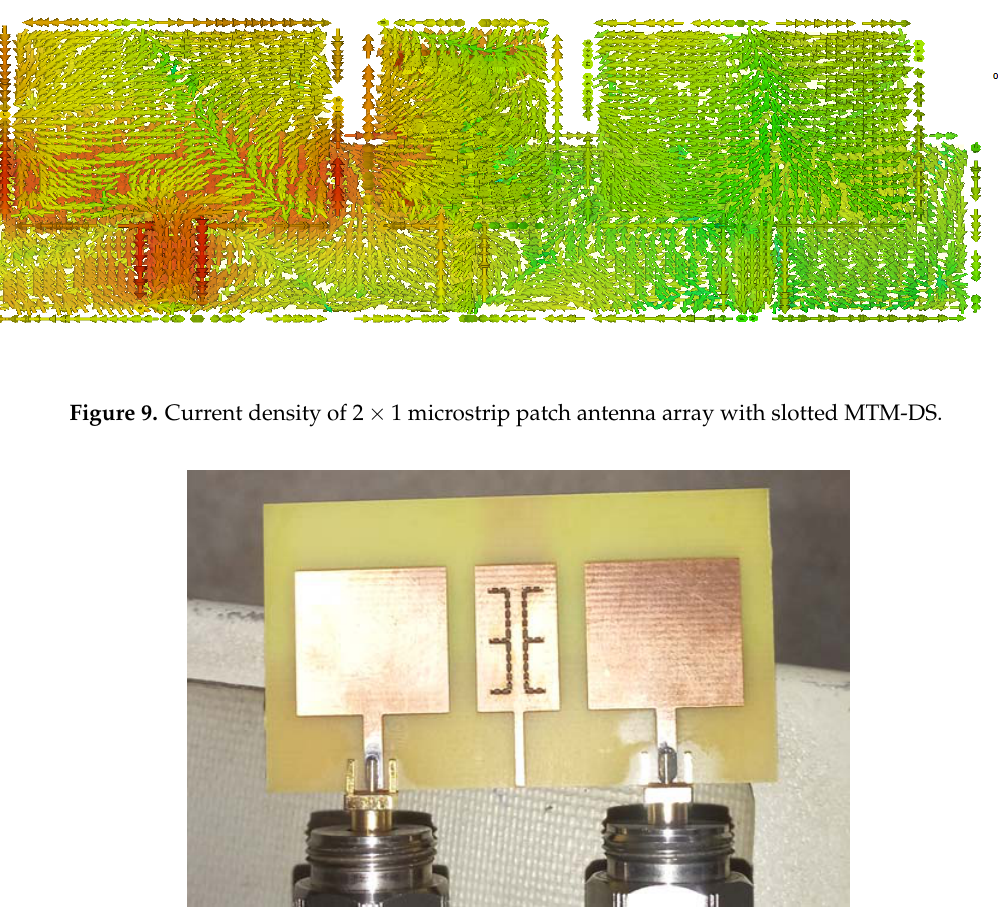
Figure 10. Photograph of the fabricated antenna array with slotted MTM-DS.